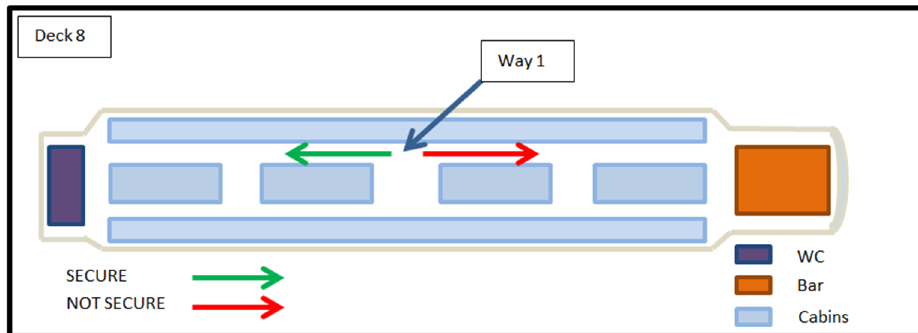
Figure 2. Evacuation simulation model .